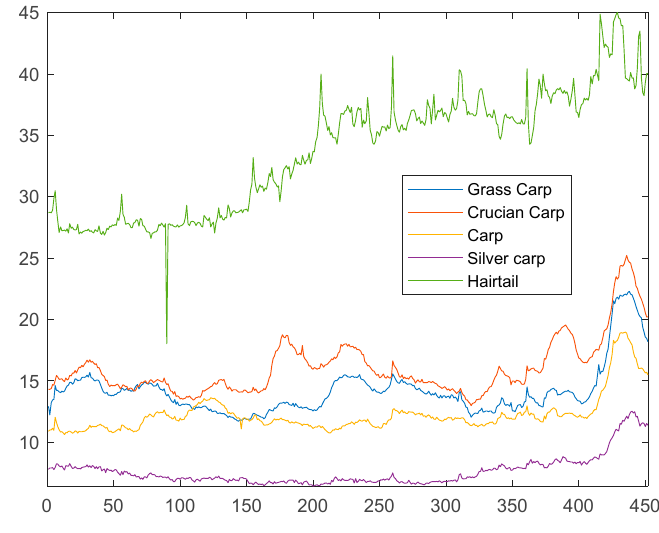
Figure 3. Dataset images.